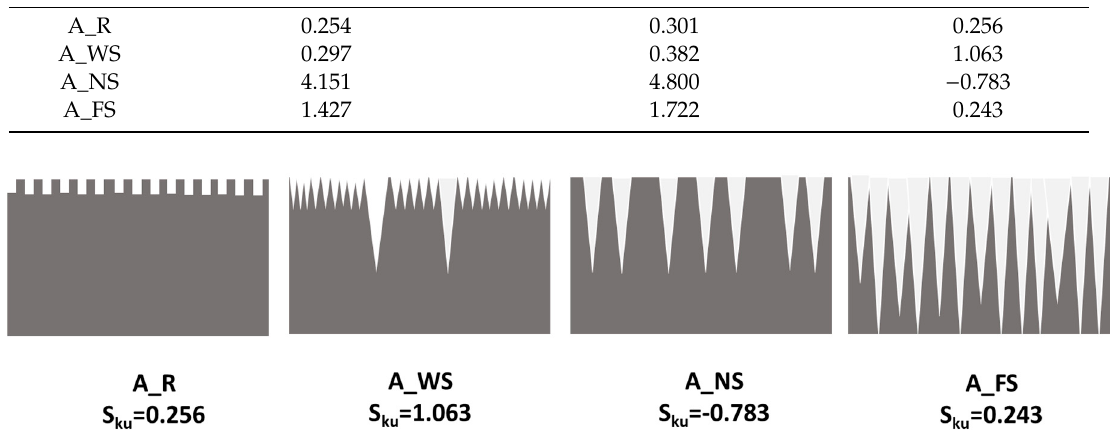
Figure 2. Scheme of the as-received (A_R), A_WS, A_NS, and A_FS profiles.